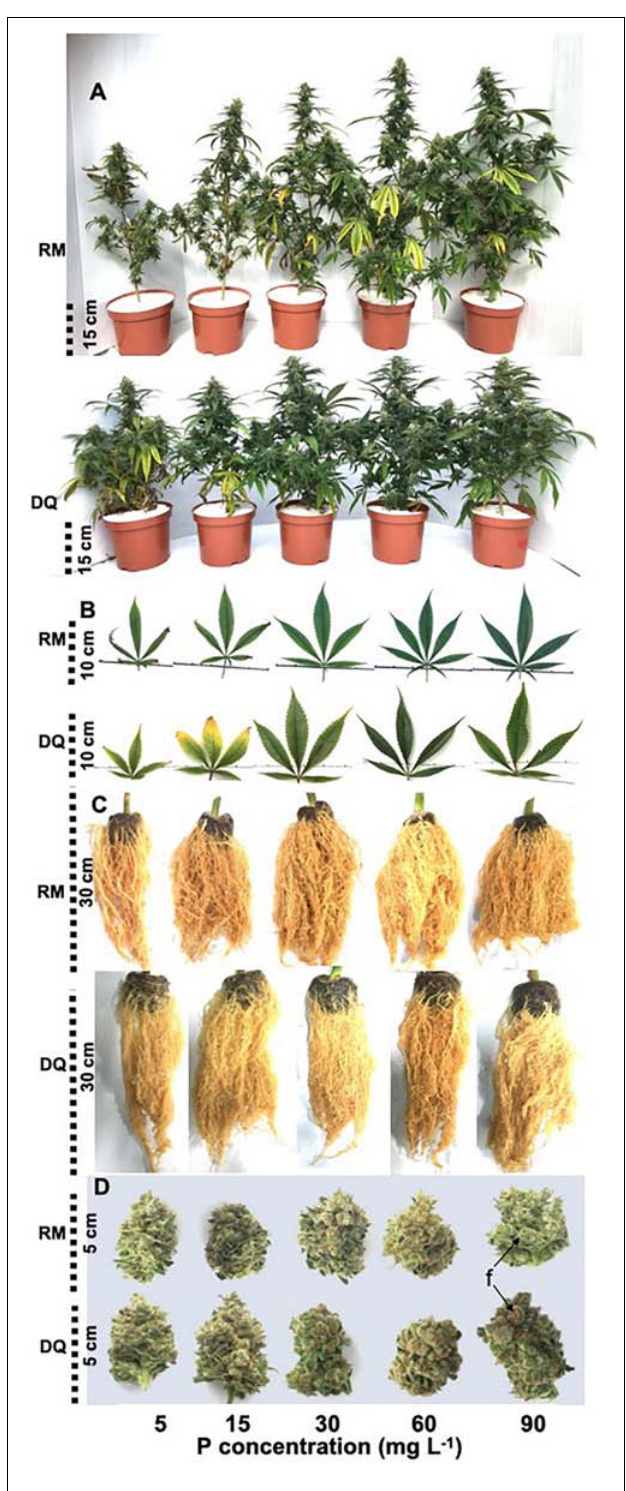
FIGURE 3 | Effect of P supply on visual appearance of whole plants (A) , leaves (B) , roots (C) , and trimmed inflorescences (D) of two medical cannabis cultivars RM and DQ. The images were taken at plant maturity. Shown are the apical inflorescence on the main stem and the youngest fully developed leaf on the main stem. “f” points at individual flowers in the